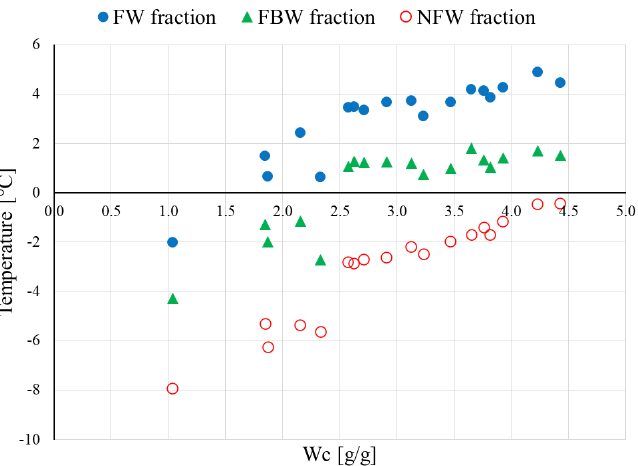
Figure 4. Raw HPC—an exemplary graph showing the dependence of the maximum temperature T max of FW, FBW, and NFW components on water concentration W c .